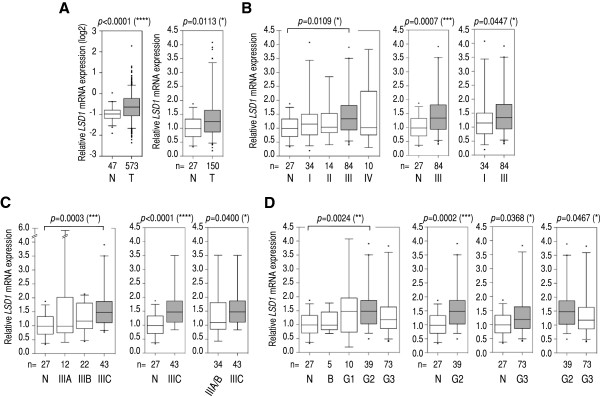
Multi- and pair-comparison statistical tests suggest moderate LSD1 mRNA overexpression in stage IIIC and grade G2/G3 specimens in our cohort. (A) Left panel: pair-comparison analysis of LSD1 mRNA levels in normal (N) and tumor (T) specimens (serous cystadenocarcinoma, TCGA cohort; log2-scale). Right panel: as in (A) but in our cohort (all tumor histological subtypes; see Additional file 3: Figure S1 for a separated analysis). (B) Left panel: multi-comparison analysis of normal tissue (N) and tumors classified by FIGO stage (I-IV). Middle and right panels: pair-comparison analyses of normal tissue (N) and stage III tumors, and stage I and stage III tumors, respectively. (C) Left panel: multiple-comparison analysis of normal tissue (N) and tumors classified as stage IIIA-IIIC. Middle and right panels: pair-comparison analyses of normal tissue (N) and stage IIIC tumors; and a pool of stage IIIA and IIIB tumors (IIIA/IIIB) and stage IIIC tumors, respectively. (D) Left panel: multiple-comparison analysis of normal tissue (N) and tumors classified by FIGO grade: borderline (B) and G1-G3. Rest of panels: left, pair-comparison analyses of normal tissue (N) and grade G2 tumors; middle, normal tissue (N) and grade G3 tumors; and right, G2 tumors and G3 tumors. We applied the Mann–Whitney test in pair-comparison analyses, and the Kruskal-Wallis (non-parametric ANOVA) test followed by post hoc Dunn’s analysis in multiple-comparison analyses (number of comparisons = 10 in B and D, and 6 in C). P-values and number of specimens are shown on top and at the bottom of each panel. Two outliers exceeded the limits of the y-axis (values = 8.3 and 5.9) in some panels. In B-D, all histological subtypes were analyzed excluding mucinous. Whiskers in box plots represent 5–95 percentile values, and horizontal lines within boxes represent median values. P-value < 0.05 (*), p-value < 0.01 (**), p-value < 0.001 (***), and p-value < 0.0001 (****).